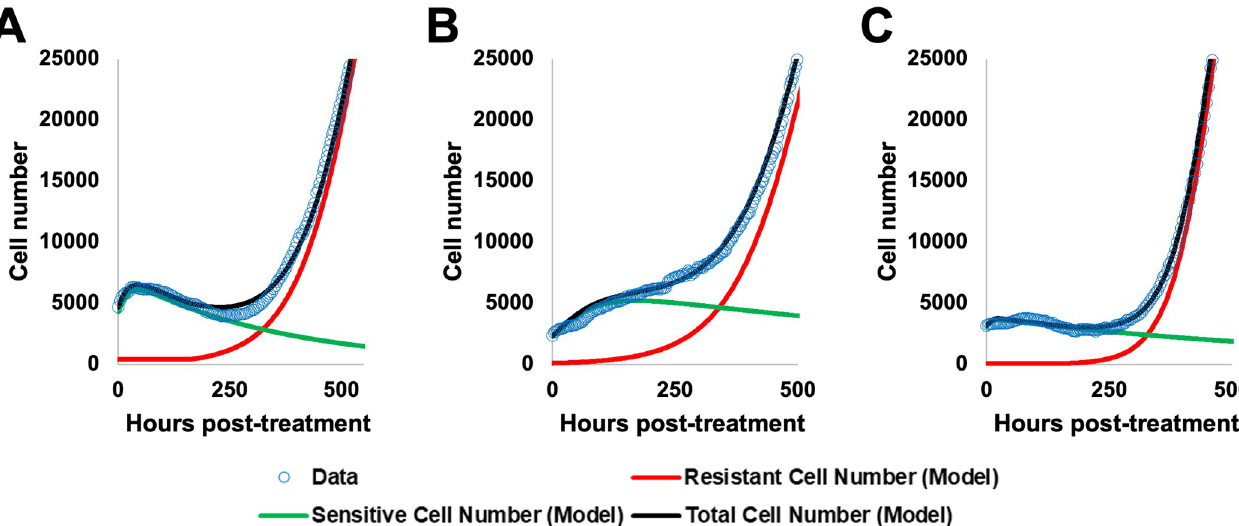
Fig 6. Examples of model fitting demonstrate the ability of model 1 to capture long term dynamics. Examples of model fitting are shown for a single replicate culture in the MCF7 (A), BT474 (B), and MDA-MB-231 (C) cell lines. The curve represents a response to the doxorubicin concentration used in serial treatment within the cell line– 75 nM for the MCF7 line, 35 nM for the BT474 cell line, and 200 nM for the MDA-MB-231 cell line. Data is shown as open blue circles, while the best-fit curve for model 1 (the total number of sensitive and resistant cells) is shown in black, with the resistant and sensitive compartments shown in red and green